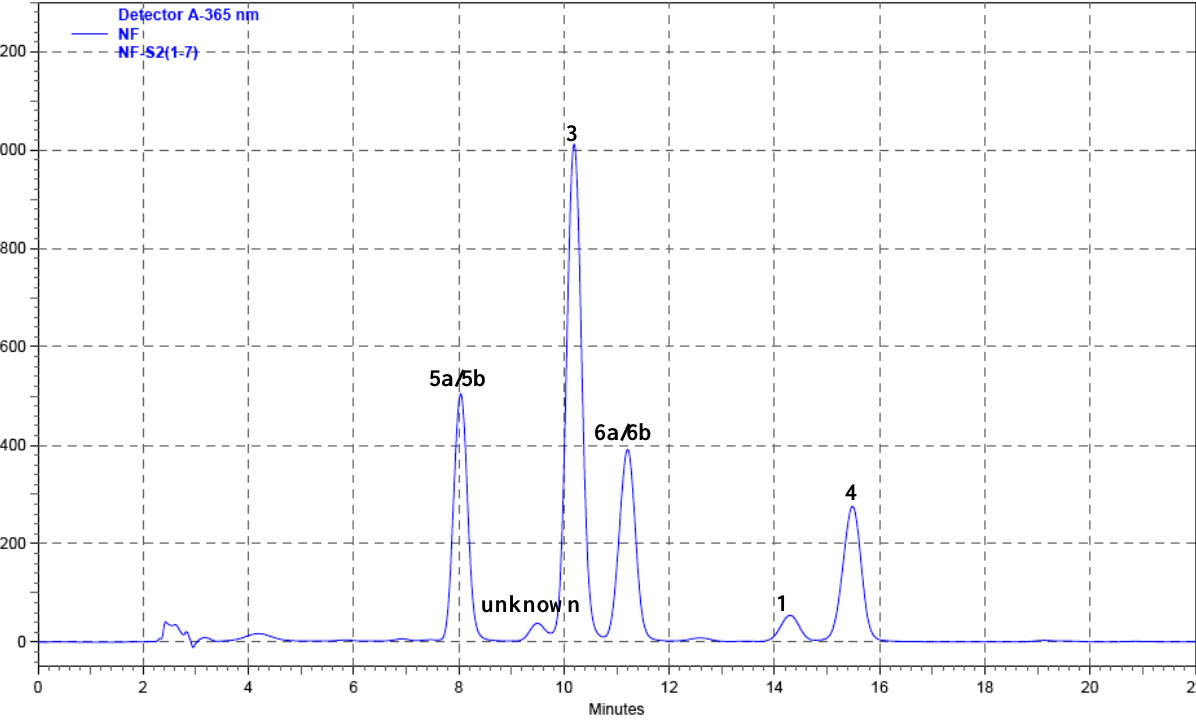
Figure 2A . Qualitative HPLC profile of a mixture of compounds 1, 3 , 4 , 5a / 5b and 6a / 6b identified in N.